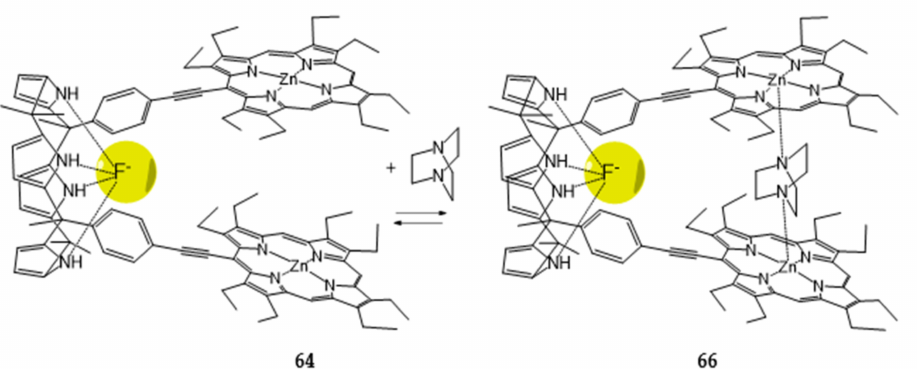
Scheme 19. 1:2 complexation of the receptor 63 with DABCO.